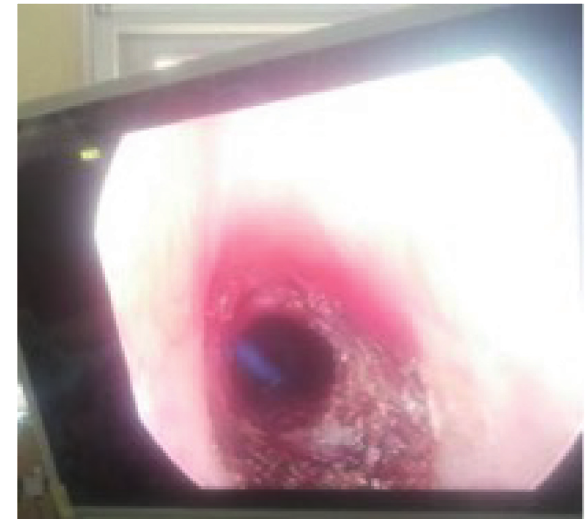
Figure 6: Postoperative picture after third sitting of bougie dilation for grade III subglottic stenosis.